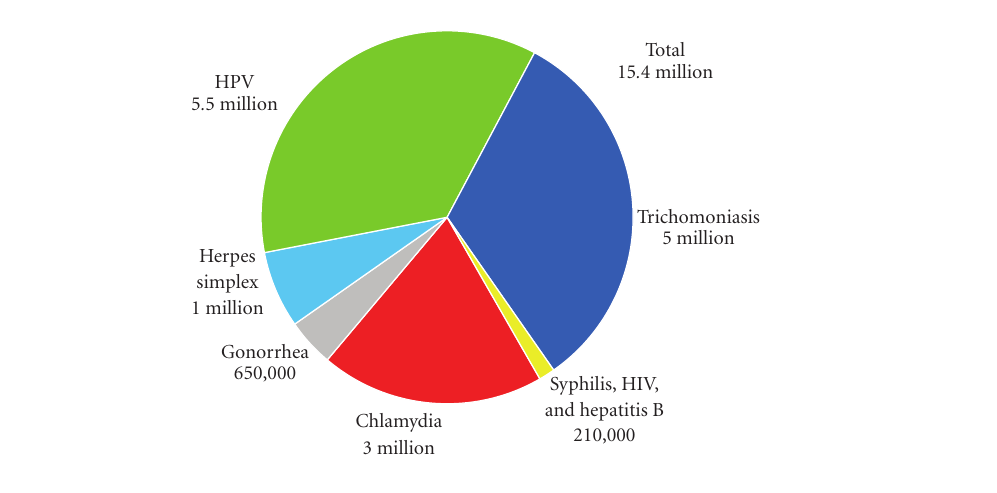
Figure 1: Estimated incidence of sexually transmitted infections in the United States [1].